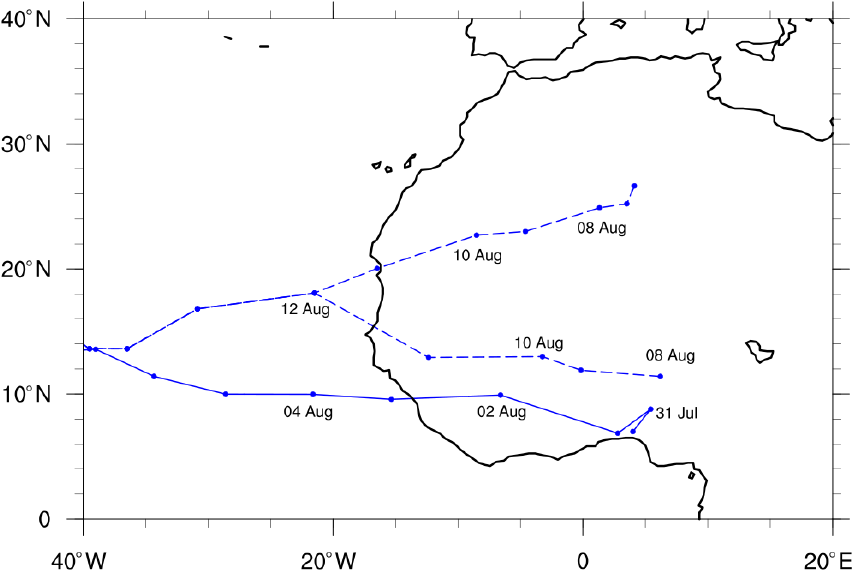
Figure 4. Daily locations (at 00:00UTC) of the AEWs corresponding to Gert (solid) and Harvey (dashed), as obtained by the tracking algorithm in the CTL run (time period in August